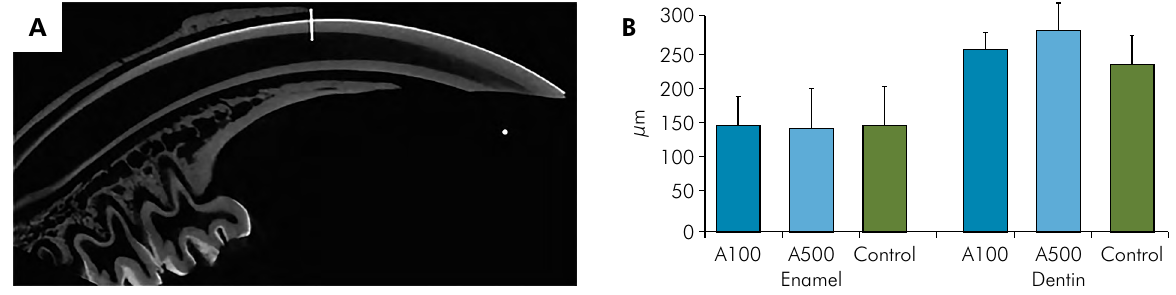
Figure 2. A. Longitudinal section of an incisor exposed to 100 mg/kg amoxicillin. The white bar indicates the point of measurement. B. A graphical representation of mean thickness of enamel and dentin with confidence intervals (95% CI). There are no significant differences between the groups. A100 = amoxicillin 100 mg/kg/day and A500 = amoxicillin 500 mg/kg